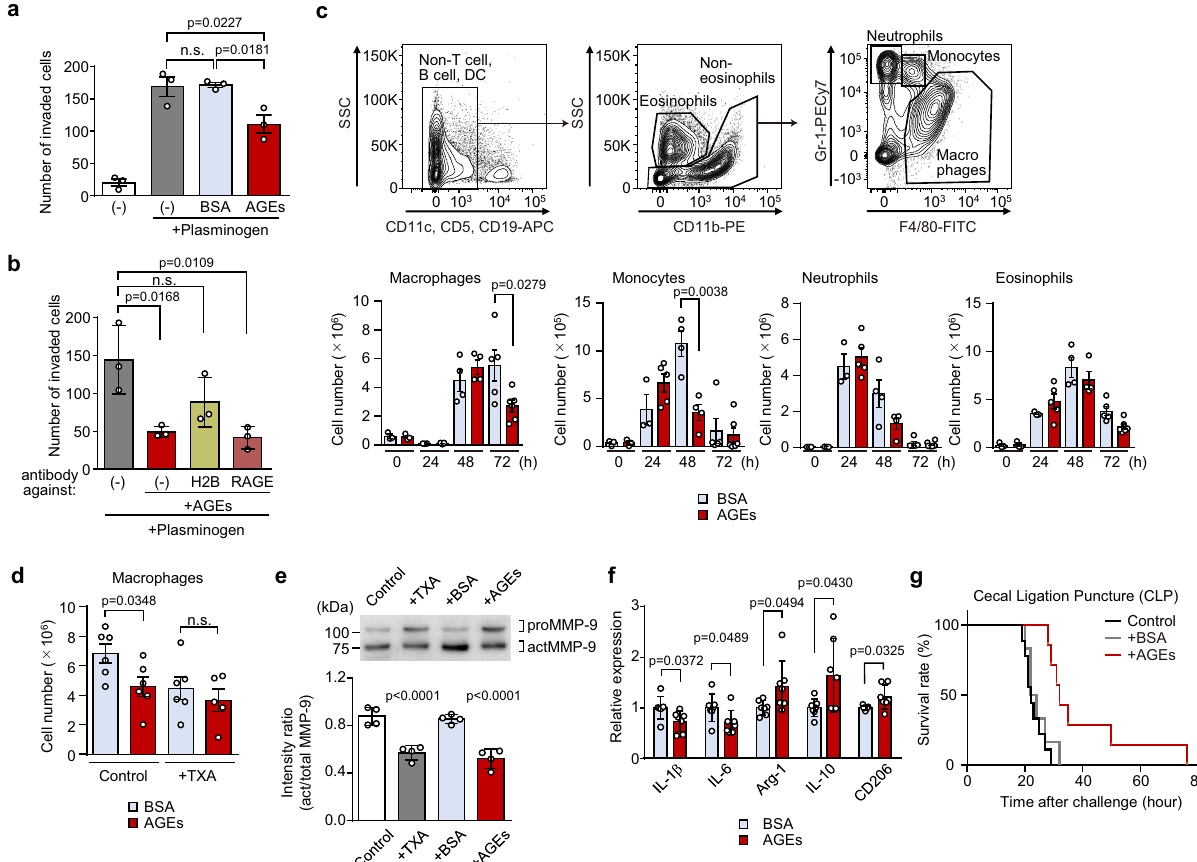
Fig. 5 AGEs regulate monocyte/macrophage recruitment to the in fl ammatory sites. a In vitro in fi ltration assay. J774A.1 cells were incubated alone or with BSA or AGEs in the presence of Plg. The in fi ltration activity was assessed by the number of cells across the Matrigel (mean ± S.D., n = 3, biologically independent experiments). Tukey – Kramer tests (two-sided), n.s. not signi fi cant ( p > 0.05). b Effect of H2B or RAGE on AGEs-dependent suppression of in fi ltration. Cells were preincubated with anti-H2B or anti-RAGE antibody and the in fi ltration activity was assessed (mean ± S.D., n = 3, biologically independent experiments). Tukey – Kramer tests (two-sided), n.s., not signi fi cant ( p > 0.05). c Effect of BSA or AGEs on the peritoneal in fi ltration. BSA or AGEs was given daily by intravenous administration and the number of peritoneal cells was determined 0, 24, 48, and 72 h after TG injection (mean ± S.D., n = 3 for BSA-0 h, AGEs-0 h, and BSA-24 h, n = 4 for BSA-48 h and AGEs-48 h, n = 5 for AGEs-24 h and BSA-72 h, n = 6 for AGEs-72 h, biologically independent experiments). Student ’ s t test (two-sided). d Inhibition of Plg activation abrogate the effect of AGEs on macrophage in fi ltration. Mice were administrated with TXA, and the number of peritoneal macrophages was determined 72 h after TG injection (mean ± S.D., n = 5 for AGEs + TXA group and n = 6 for other groups, biologically independent experiments). Student ’ s t test (two-sided), n.s. not signi fi cant ( p > 0.05). e Effect of AGEs on MMP-9 activation. MMP-9 in peritoneal lavage was puri fi ed and detected with MMP-9 antibody (upper panel), and act/proMMP-9 ratio were quanti fi ed (lower panel; mean ± S.D., n = 4, biologically independent experiments). Dunnett ’ s test (two-sided), relative to the control. f Expression levels of proin fl ammatory and anti-in fl ammatory macrophage markers in peritoneal macrophage. Data are relative expression to BSA-treated mice (mean ± S.D., n = 7, biologically independent experiments). Student ’ s t test (two-sided). g Effect of AGEs on sepsis model. Mice were treated with saline ( n = 9, black line), BSA ( n = 6, gray line), or AGEs ( n = 7, brown line) 4 h after the CLP procedure. There were signi fi cant differences in the treatment with saline vs. AGEs and with BSA vs. AGEs, but not with saline vs. BSA ( p = 0.0004, 0.0099, and 0.4154, respectively, log-rank